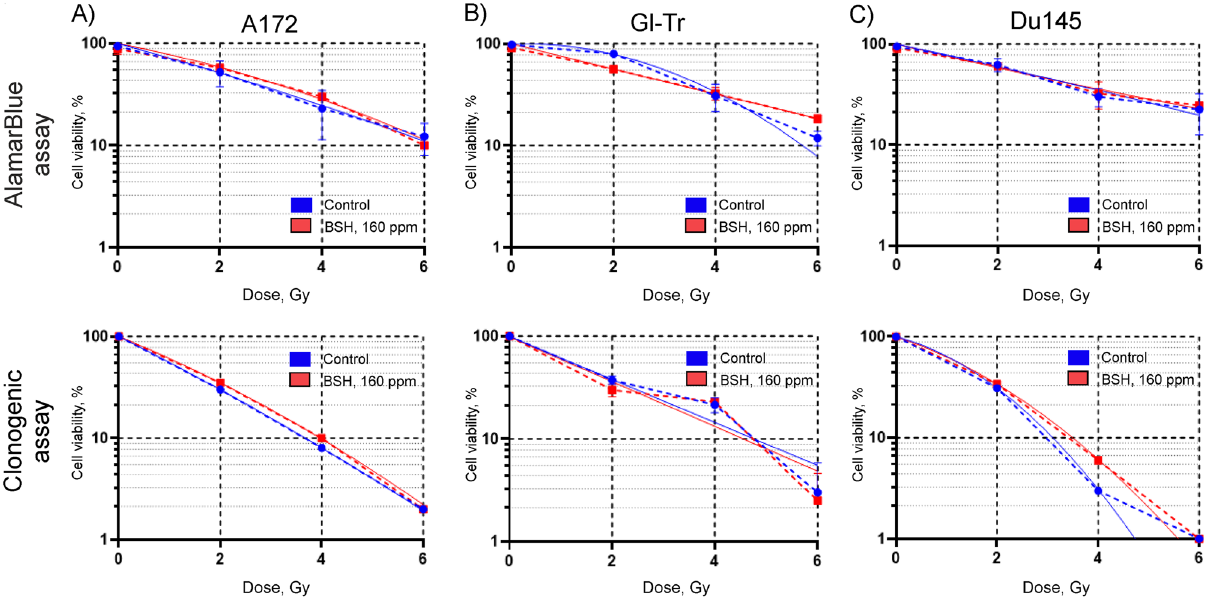
Figure 6. Cell viability after incubation of cells with 160 ppm of boron-11 and exposure to Bragg peak of 89.7 MeV clinical proton beam. Summary plots for AlamarBlue (up panels) and colony forming assays (bottom panel): ( A ) A172 cells, ( B ) Gl-Tr cells, ( C ) Du145 cells. The cells were incubated in a medium containing 160 ppm of boron-11 for 18 h and then irradiated at the distal position of 89.7 MeV clinical SOBP in a